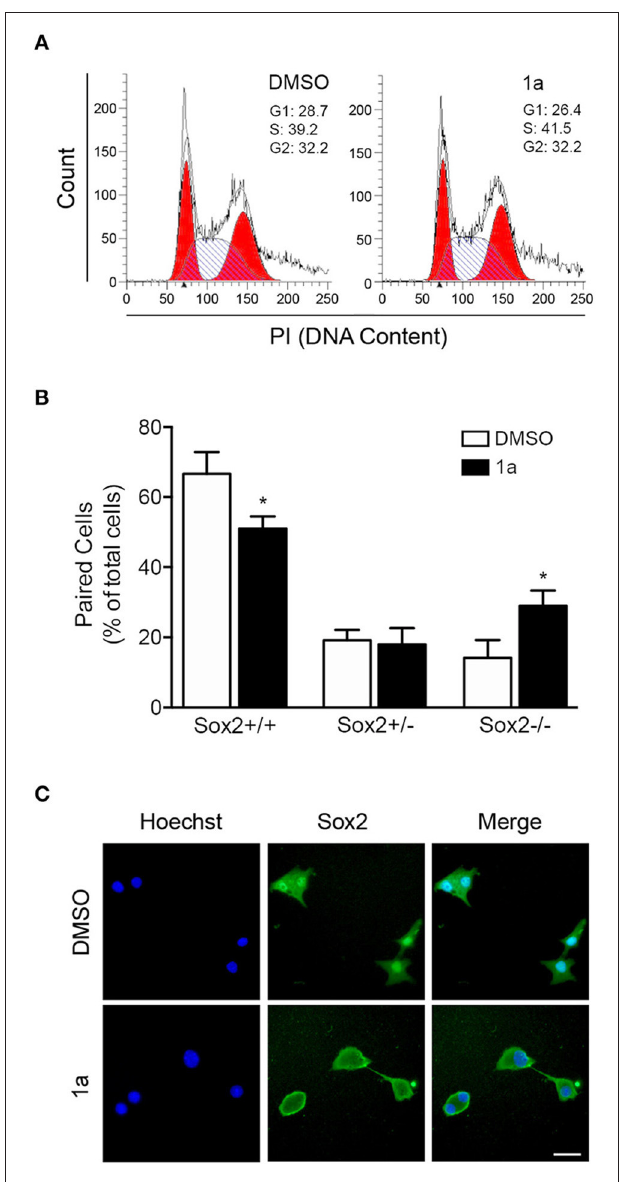
FIGURE 5 | Spiropyrazoline oxindole 1a decreases NSC self-renewal through a cell cycle independent manner. Mouse NSCs were treated with compound 1a at 12.5 µ M or DMSO (control) for 24h and collected for flow cytometry and cell-pair assays as described in Experimental . (A) Effect of compound 1a on cell cycle progression. Cellular DNA was stained with propidium iodide (PI) in differentiation conditions to determine cell cycle distribution. (B) Representative quantification data of paired cells Sox2-positive and -negative, in low EGF/bFGF containing medium after 1a treatment. (C) Representative microscopy images of undifferentiated NSC pairs labeled with Hoechst 33258 for nuclei staining and anti-Sox2 antibody after 1a treatment. Scale bar, 25 µ m. Results are expressed as mean ± SEM fold-change for at least three different experiments. * p < 0.05 from control by Student’s t -test.